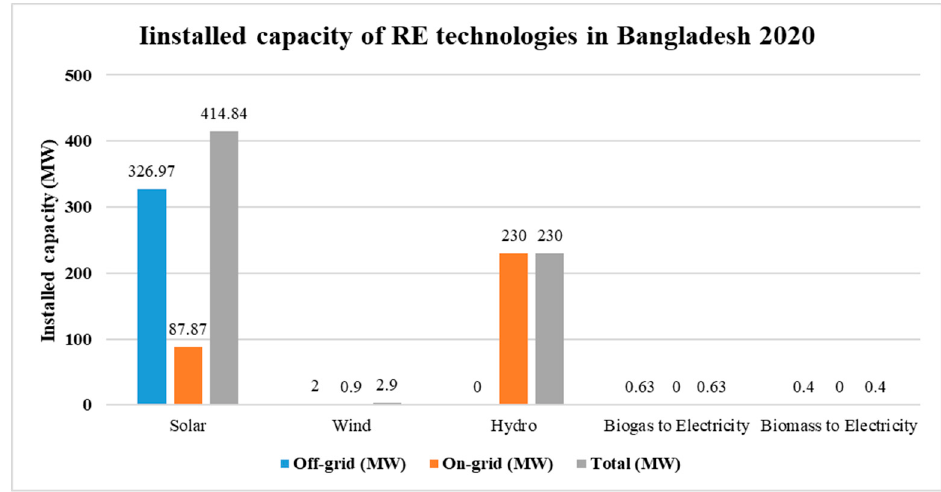
Figure 2. Installed capacity of RE technologies for electricity generation in Bangladesh as of 2020 [25].